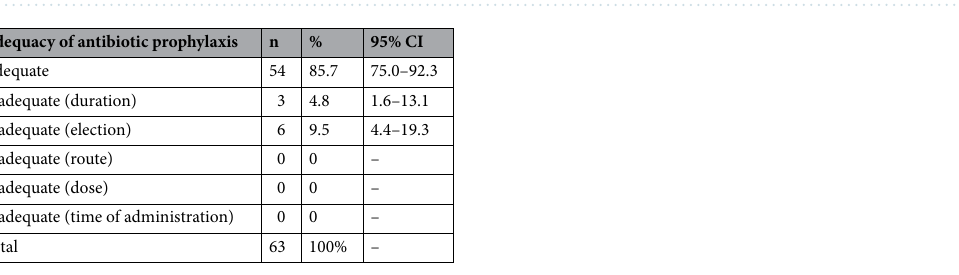
Table 4. Compliance and adequacy of antibiotic prophylaxis use to the hospital protocol (n = 76, compliance